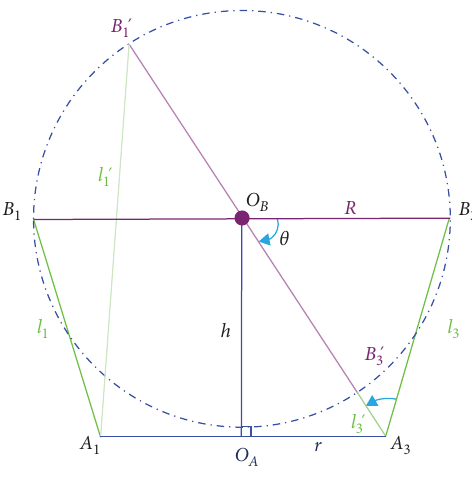
F IGURE 9: Statics